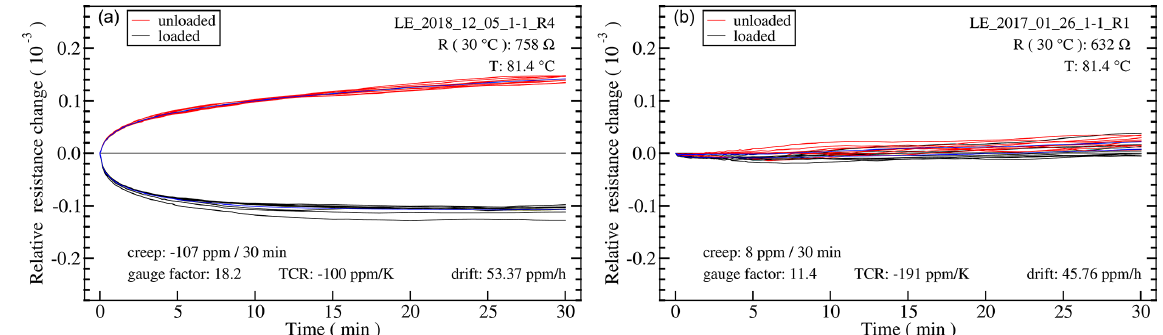
Figure 2. Typical plot of a creep measurement with 10 repetitions at a temperature of about 81 ◦ C. The relative change of resistance after the load change is plotted in parts per thousand on the ordinate. (a) Ni–C as-deposited (sample 1 initial ) (b) Ni 90 Cr 10 -C as-deposited (sample 2 initial ). From these measurements, characteristic values are calculated for the quantities: creep, gauge factor, TCR, and drift. These values are displayed in the graphs. During the time of the measurement (30min), the resistance also changes due to drift, the value of which is given in the figures. As a result, the curves become asymmetric, since there is a superimposed drift to higher resistance values. Table 1. Initial mechano-electrical quantities of layers derived from the described measurements. These are the as-deposited or initial values without any post heat treatment. In the last column, some characteristic microscopic structural features of the layers are noted, which will be explained